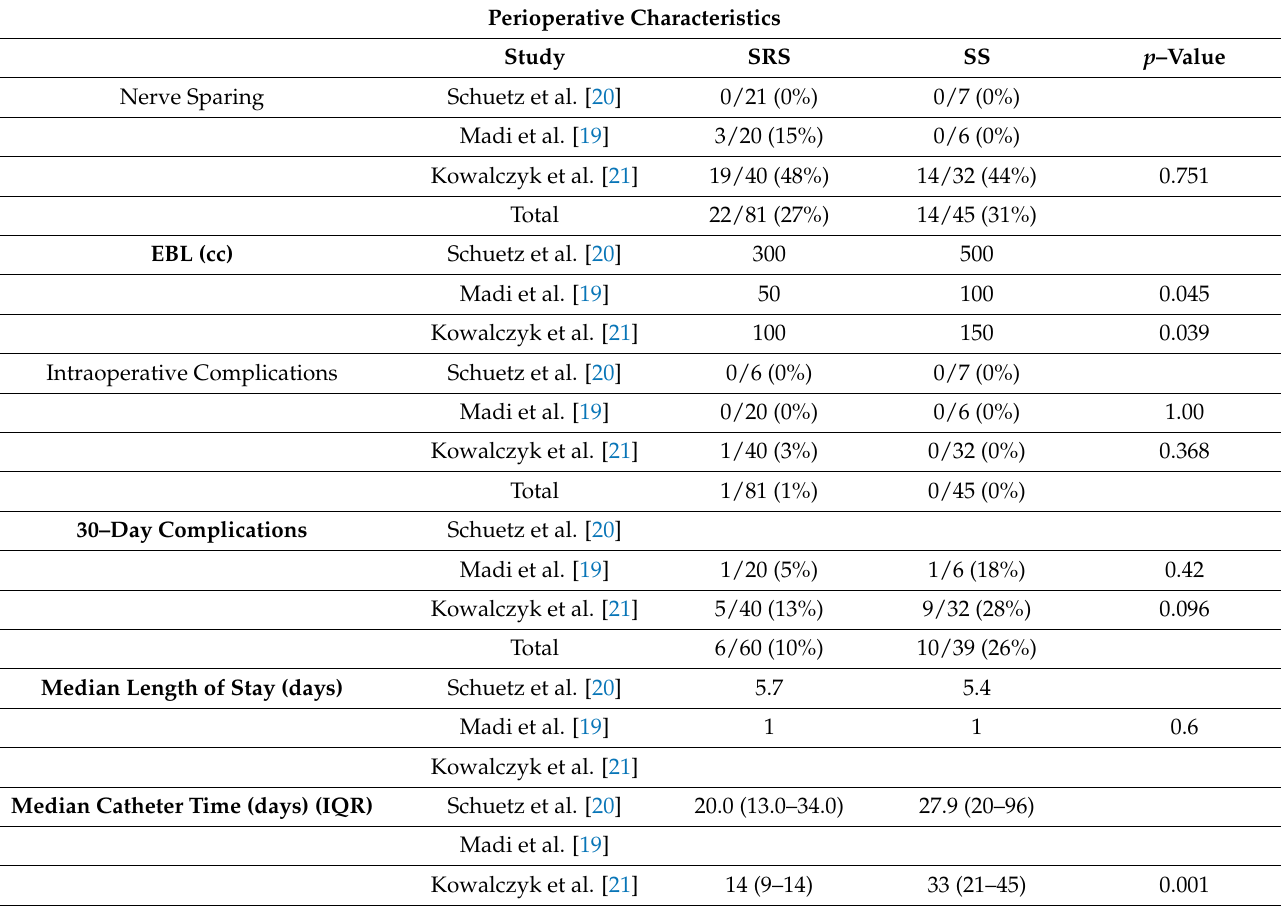
Table 2. Perioperative Characteristics. 27% of RS-RARP patients underwent nerve-sparing ap- proaches compared to 31% of S-RARP. Estimated blood loss (EBL) was reduced in RS-RARP. There was 1 intraoperative complication in RS-RARP (ureteral injury) compared to 0 in S-RARP. 30-day complica- tions were 10% in RS-RARP compared to 26% in S-RARP. Median length of stay was similar when reported. Median catheter time was shorter in RS-RARP groups at 20.0 days (IQR 13.0–34.0) vs. 27.9 (IQR 20–96) in Schuetz et al. [20], and 14 days (IQR 9–14) vs. 33 (IQR 21–45) in Kowalczyk et al.